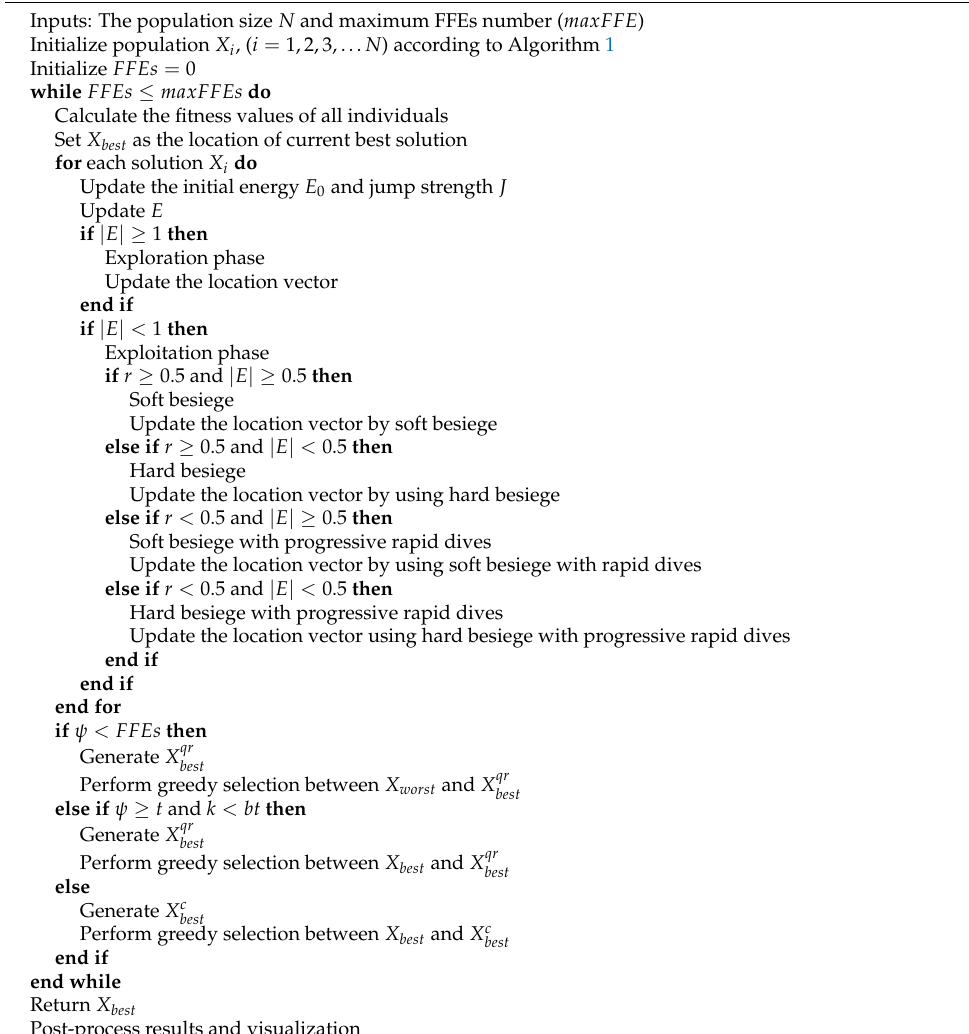
Algorithm 2 Proposed eHHO